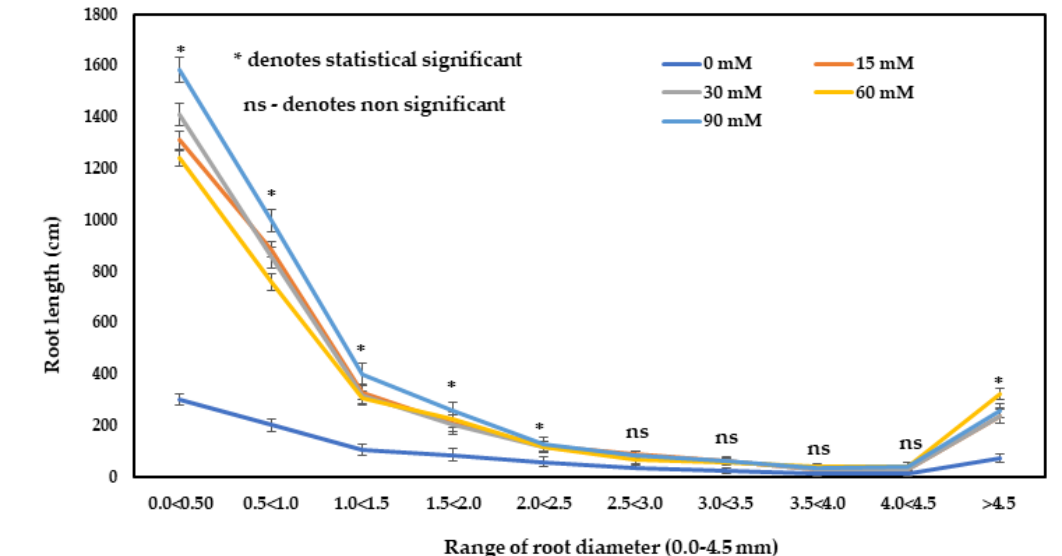
Figure 4. The influence of H 2 O 2 on the fine root length (total) of F. deltoidea plants. Fine root length was classified according to various diameter classes; fine root (>0.0–2.0 mm) and thin roots (>2.0 mm). Fine root length was higher in all treated plants compared to the control group. Error bars indicate ± standard error (S. E.).